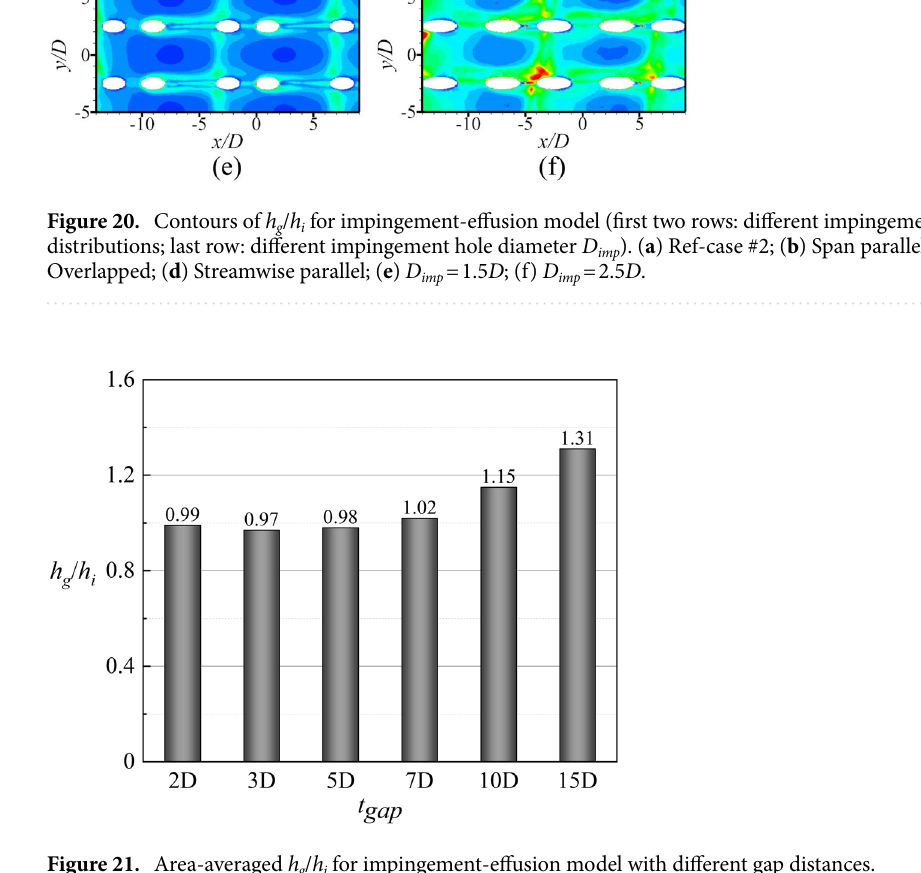
Figure 21. Area-averaged h g / h i for impingement-effusion model with different gap